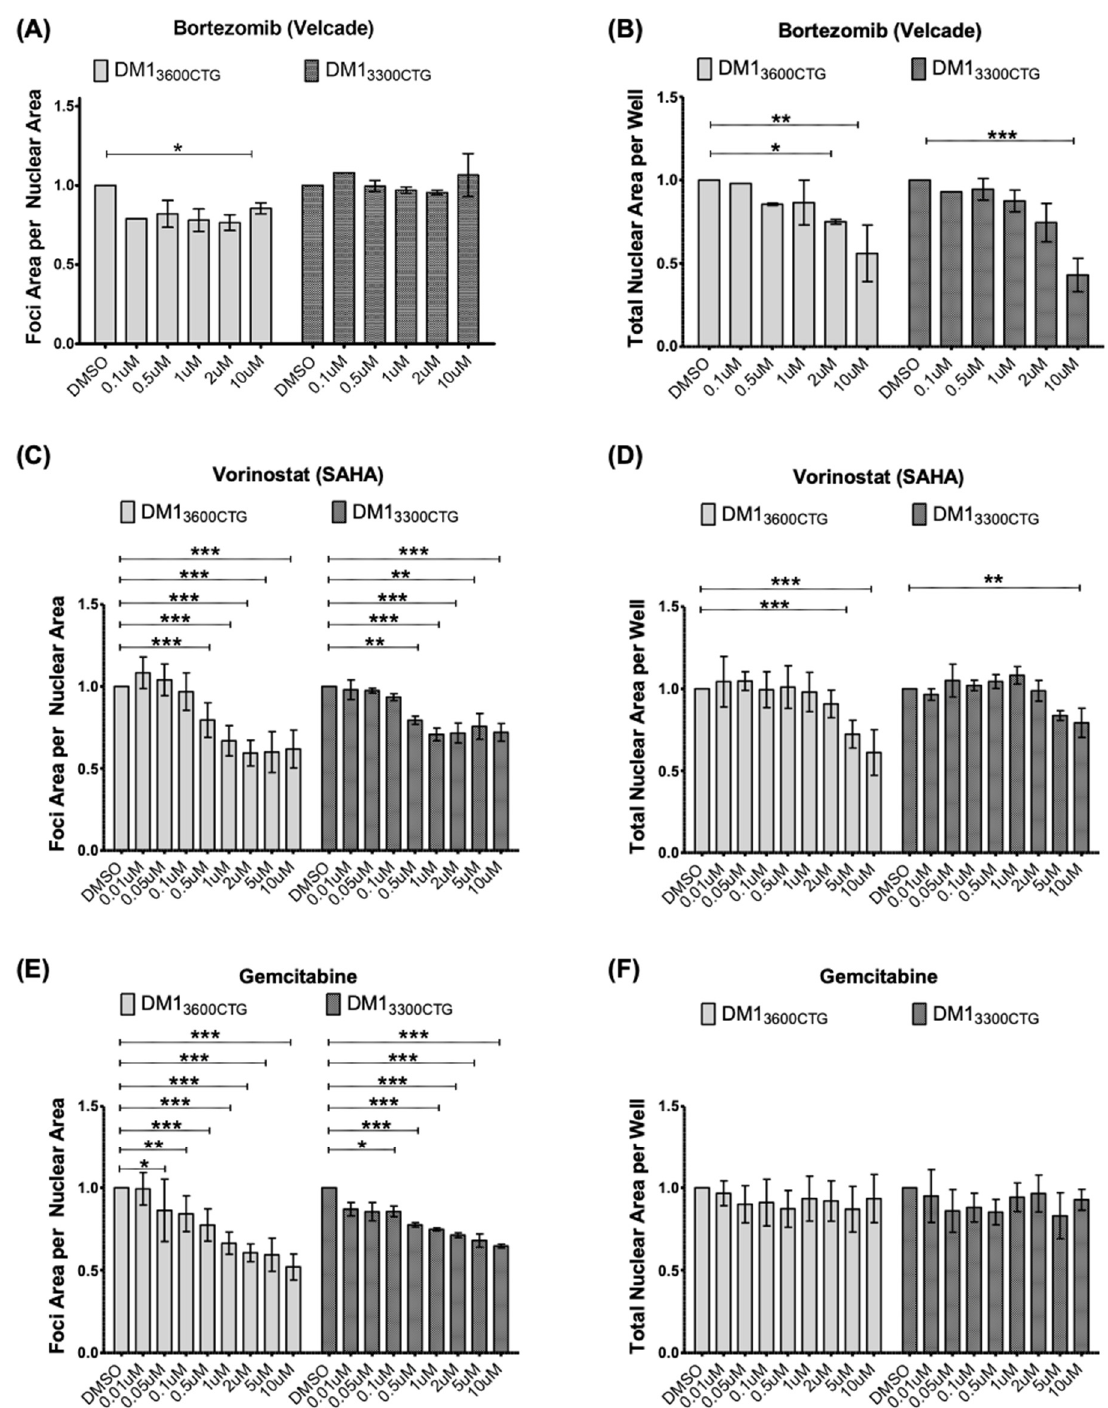
Figure 2. Bortezomib minimally reduced foci; vorinostat (SAHA) and gemcitabine reduced foci in both DM1 3600CTG and DM1 3300CTG differentiated myoblasts. DM1 3600CTG and DM1 3300CTG myoblasts were serum-starved in 384-well plates for 7 days and treated with 0.1–10 µM of ( A , B ) bortezomib, ( C , D ) vorinostat (SAHA), and ( E , F ) gemcitabine. Post-treatment, cells were fixed with 4% PFA, DNA was stained with Hoechst and CUG RNA foci were probed by Alexa555-(CAG) 10 fluorescent oligo. ( A , C , E ) Foci area per nuclear area and ( B , D , F ) total nuclear area per well (to assess treatment-associated toxicity) were quantified using Columbus and normalized to DMSO control; data is presented as fold-change relative to DMSO treatment ( n ranges from 1 (for Bortezomib 0.1 µM) to 8, two-way ANOVA ; error bars represent SD). * p < 0.05, ** p < 0.01, *** p < 0.001.